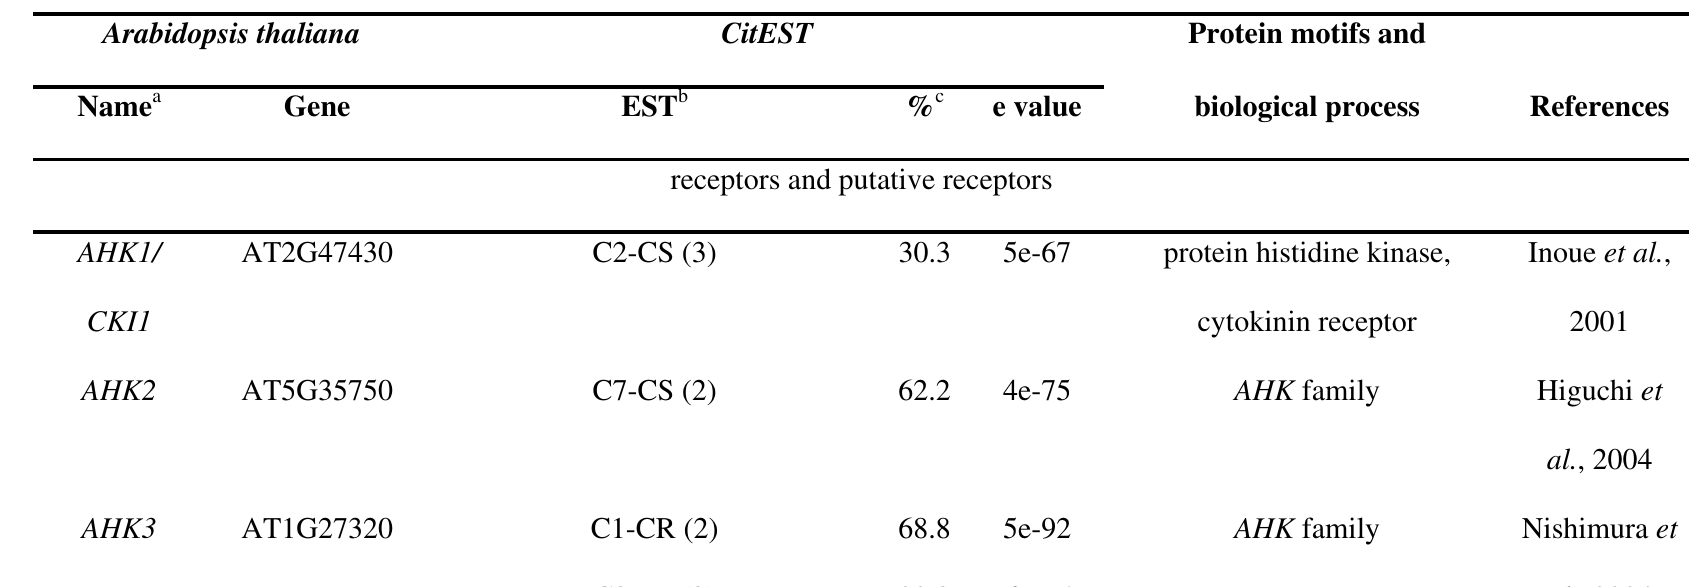
Table S7 – Citrus ESTs with homology to genes involved in cytokinin signal transduction in Arabidopsis thaliana